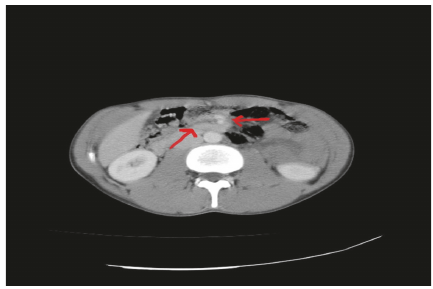
Figure 4: Ladd’s band. The structure between the two arrows shows Ladd’s band.